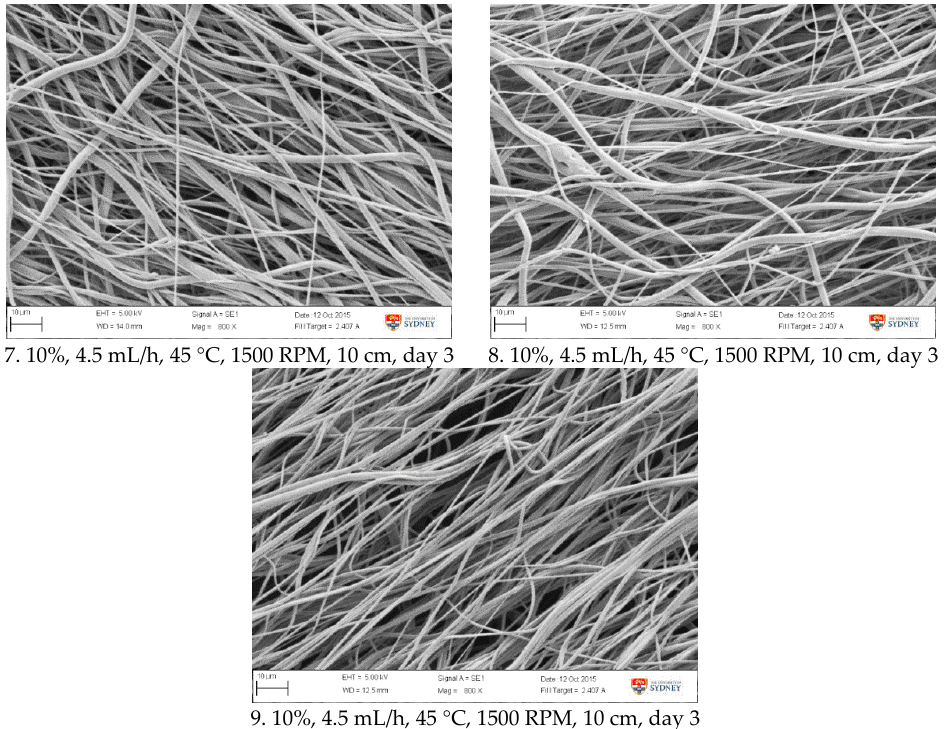
Figure A2. SEM images of fibre morphology from confirmation tests